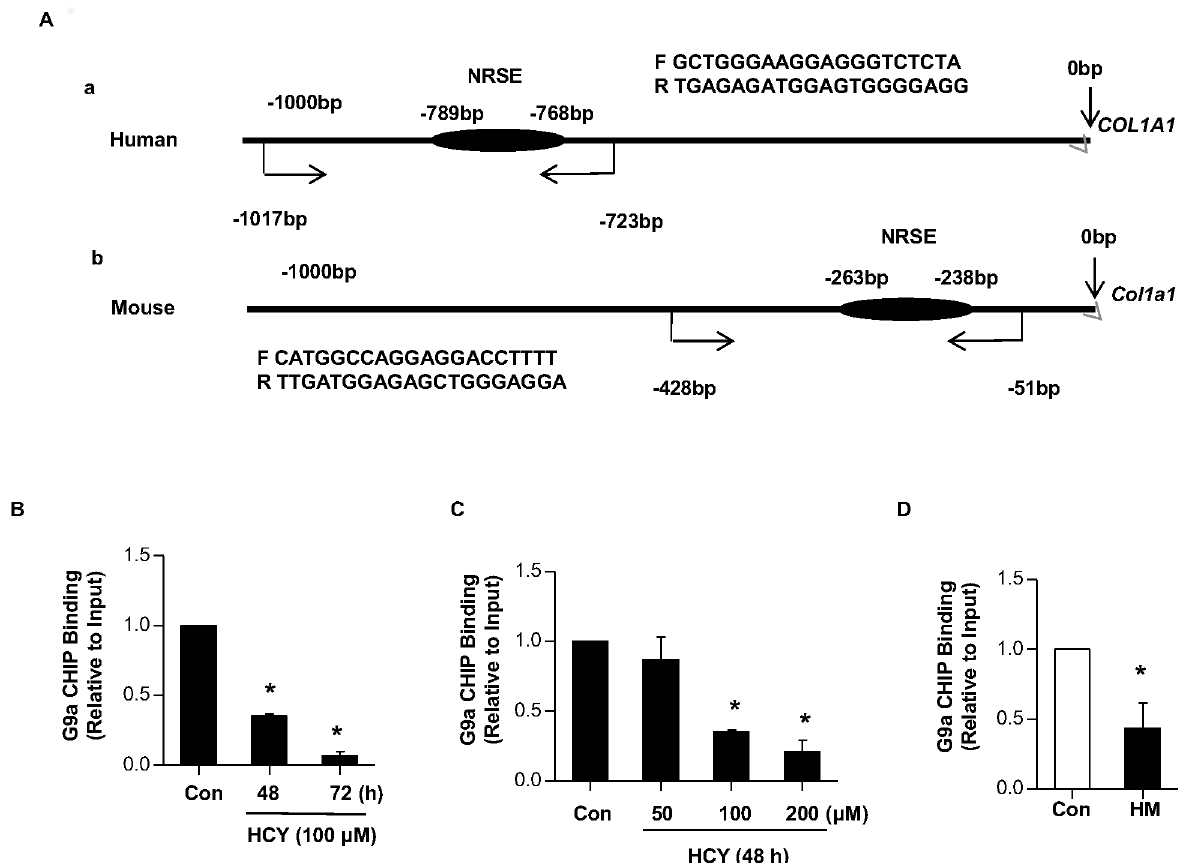
Fig 4. Hcy decreased the binding of G9a to the COL1A1 promoter. (A) Schematic representation of the promoters of COL1A1 and Col1 α 1 gene. NRSE region and primers used for ChIP assay were marked. (B-C) LO2 cells were treated with 100 μ M of Hcy for indicated time period (B), or indicated concentration of Hcy for 48 h (C), and then harvested for ChIP assay by using anti-G9a antibody. The changes in G9a on the COL1A1 promoter were examined by q-ChIP PCR. Data are means ± SD of three independent experiments. * p < 0.05 versus untreated cells. (D) Liver tissues of wild type mice and HHcy mice were collected for ChIP assay by using anti-G9a antibody. The changes in G9a on the Col1 α 1 promoter were examined by q-ChIP PCR. Data are expressed as mean ± SD, n = 6. * p < 0.05 versus mice fed with regular rodent